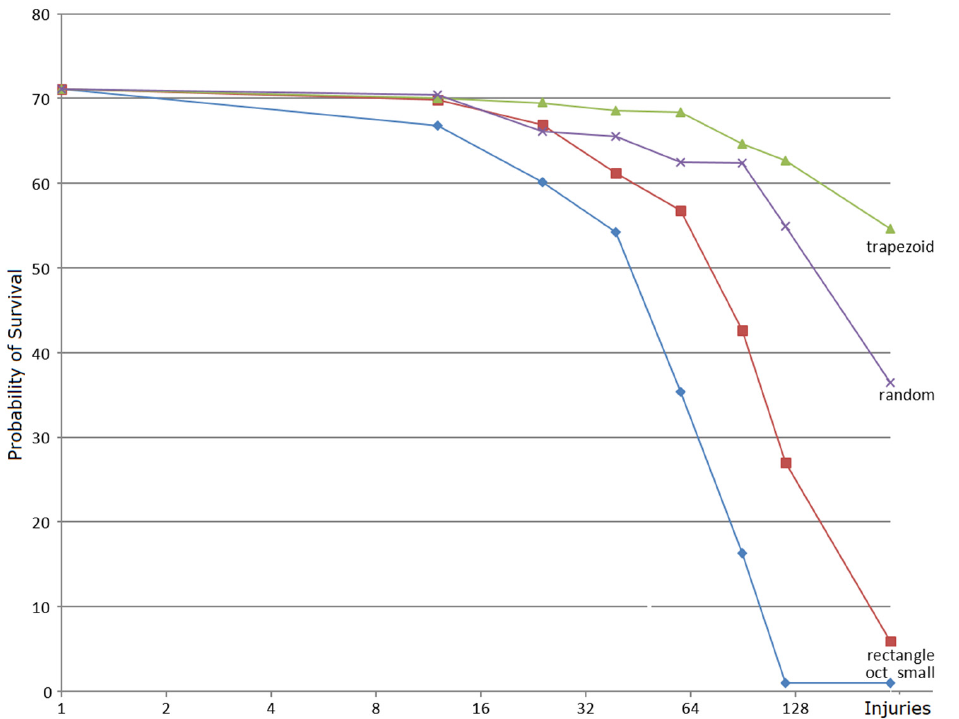
Figure 5. Assessment of robustness of the M bac system. The x -axis shows the total number of injuries of four kinds of sensitive components inflicted to the system. The y -axis is the probability of survival when x injuries of each kind are inflicted on the system.